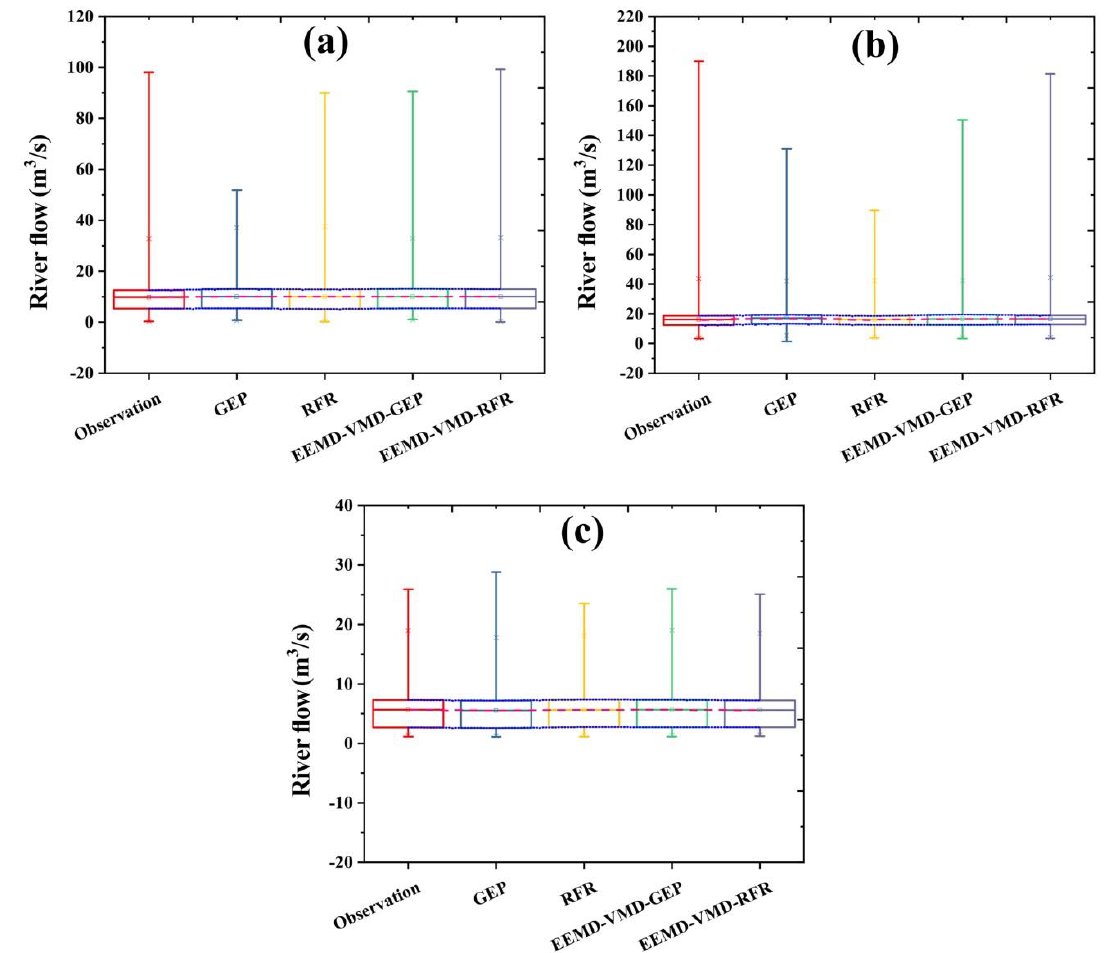
Figure 13. Boxplots of the measured and predicted daily streamflow by the standalone (i.e., GEP and RFR) and hybrid ensemble (i.e., EEMD-VMD-GEP and EEMD-VMD-RFR) models in the validation phase. ( a ) Siira, ( b ) Bilghan, and ( c ) Gachsar stations.